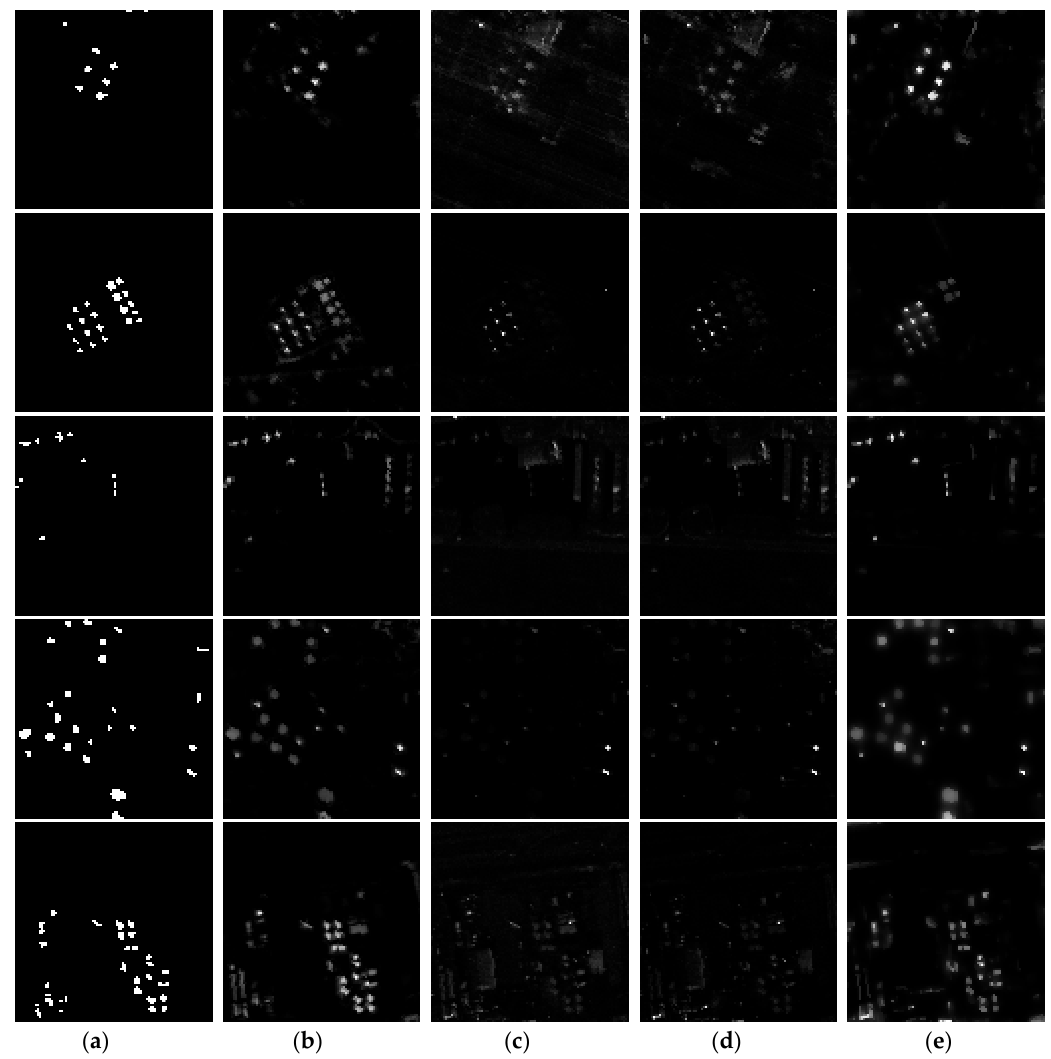
Figure 6. ABU-Urban detection map of the compared methods. ( a ) Reference map, ( b ) MPAF, ( c ) RX, ( d ) FrFE-RX, ( e ) AED.